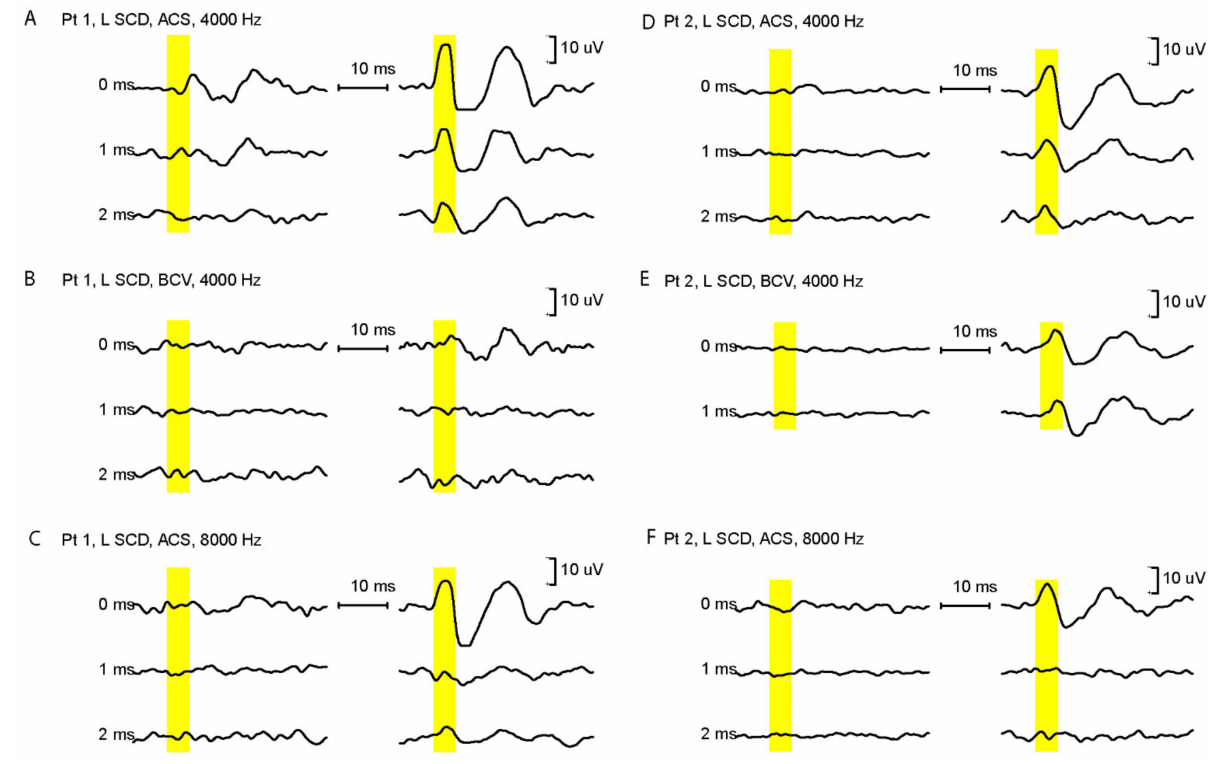
Figure 1. ( A – F ) Examples of the oVEMP n10 in response to 4000 Hz BCV and ACS stimuli at rise times of 0, 1, and 2 ms for two patients. The yellow bars define the regions for the oVEMP n10. The oVEMP for the SCD ear is shown in the right columns. Increasing the rise time from 0 to 2 ms decreases the amplitude of the oVEMP n10. In these patients, we also tested the same rise times with 8000 Hz ACS stimulus ( C , F ). While a rise time of 0 ms at 8000 Hz generates a clear oVEMP in both patients, prolonging the rise time to only 1 ms abolishes the oVEMP n10. These results confirm that events at the very onset of the high frequency stimulus are of major importance in initiating the oVEMP n10.